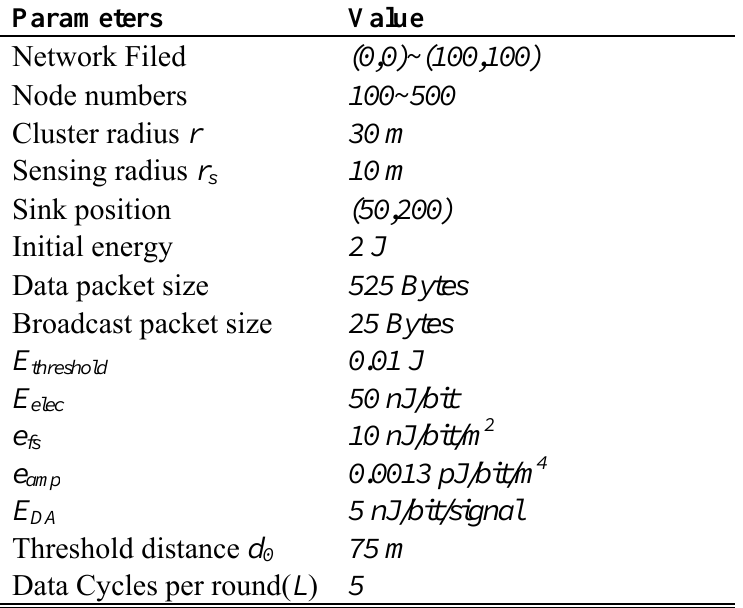
Table 3 . Simulation Parameters.